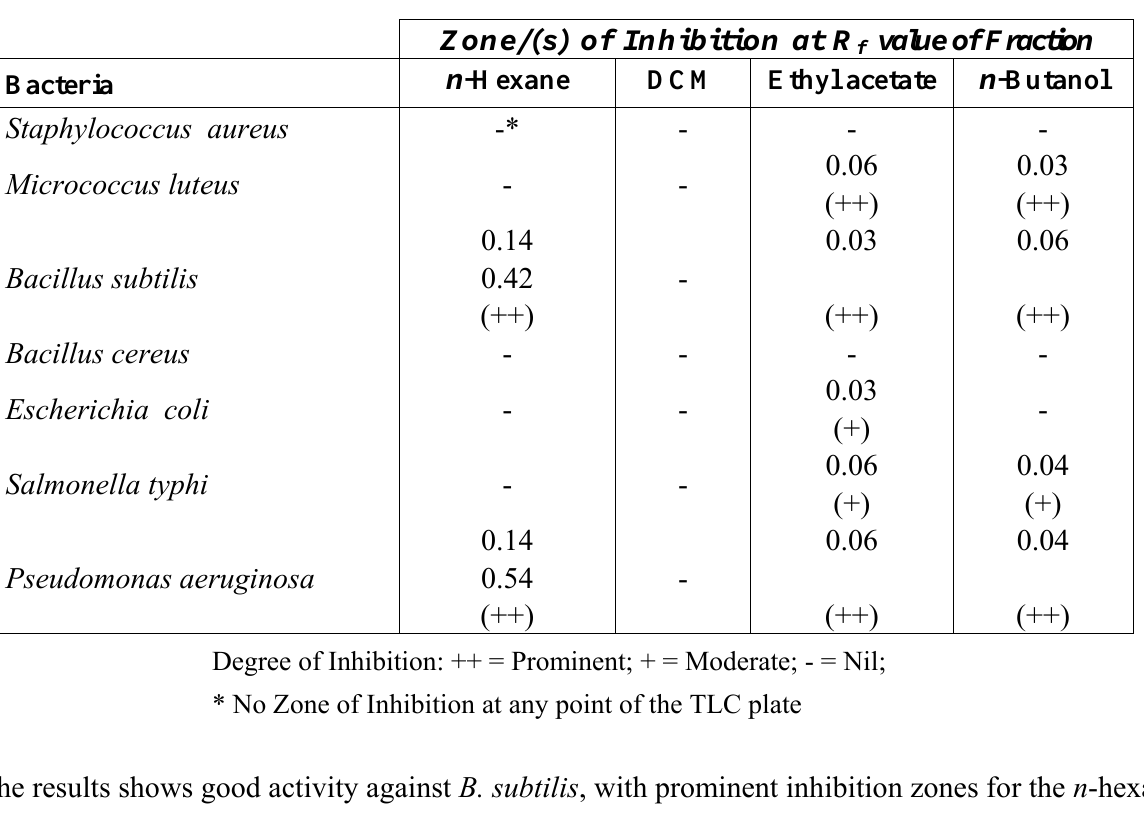
Table 2 . Location and Prominence of Zones of Inhibition at Different R Dodonaea viscosa fractions against Test